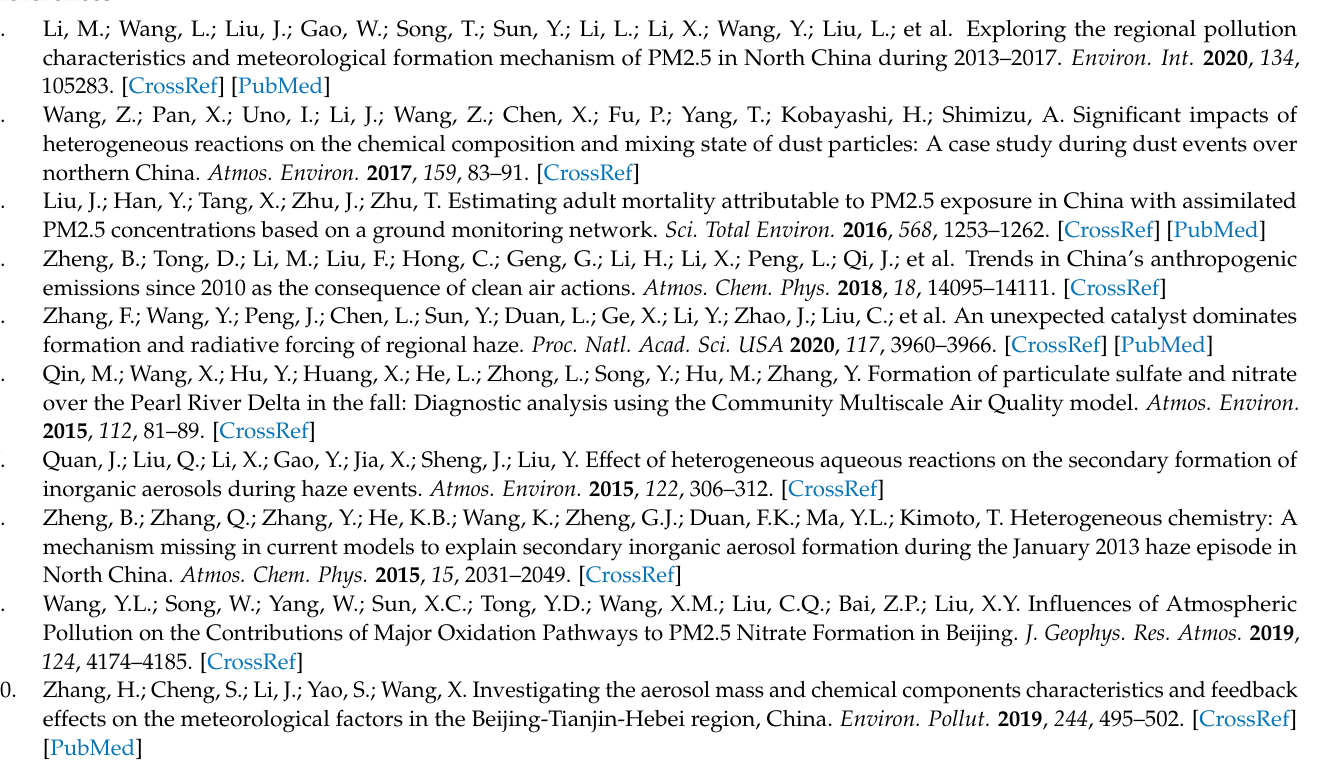
daily averaged meteorological parameters at the Tianjin site from 1 October 2017 to 31 March 2018; Figure S2: Comparison of the simulated and observed (black solid cycles) daily sulfate (a), nitrate (b), ammonium (c), and PM 2.5 (d) concentrations averaged over the 28 monitoring sites in North China Plain from 1 October 2017 to 31 March 2018. The black dots correspond to the observations, and the red and blue lines indicate the simulations of the base run and the run with bias correction scheme I, respectively; Figure S3: Rose diagram of the statistical indicators for the simulation of sulfate, nitrate and ammonium in the different cases of R9. The radius of each sector represents the degree of correlation between the simulations and observations, the radian indicates the RMSE, the different colors indicate the MB, and the value in the shaded block is the MB value; Table S1: The 28 heterogeneous reactions considered in the NAQPMS; Table S2: Sensitivity tests of the uptake coefficients of R9; Table S2: Sensitivity tests of the uptake coefficients of